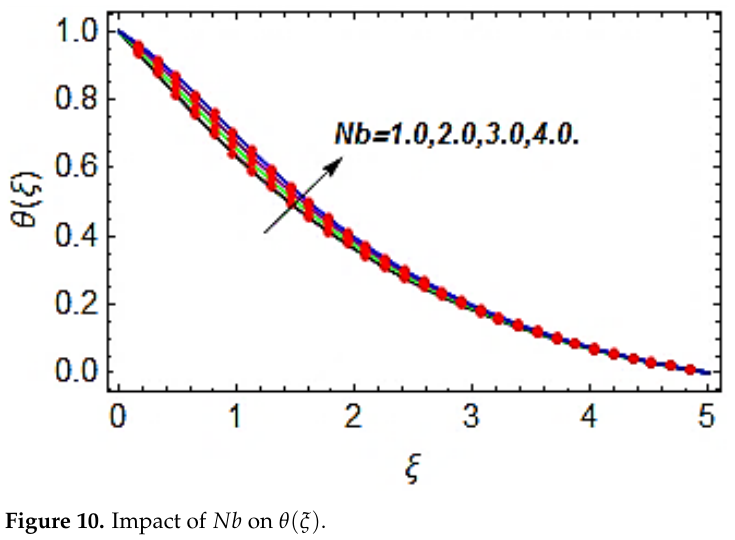
Figure 10. Impact of Nb on θ ( ξ ) .